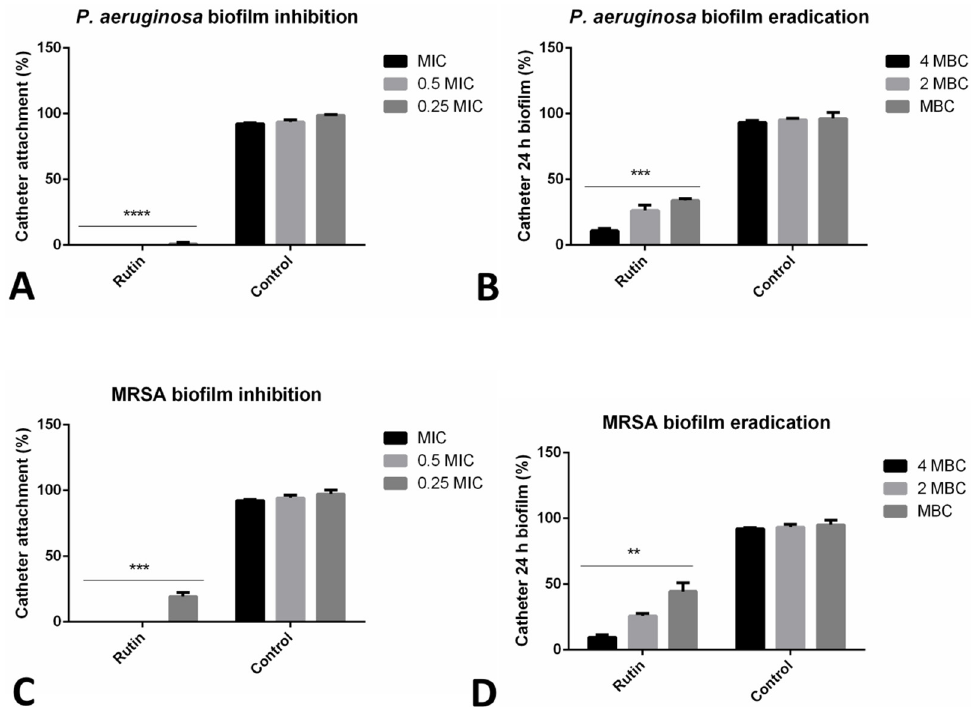
Figure 2. Impact of rutin on biofilm prevention and biofilm eradication on catheter biofilm model. P. aeruginosa IBRS P001 cell attachment on catheter surface ( A ); 24 h old P. aeruginosa biofilm ( B ); MRSA IBRS MRSA011 cell attachment on catheter surface ( C ) and 24 h old MRSA biofilms ( D ) upon treatment with rutin. The asterisks represent statistical significance **, p ≤ 0.01; ***, p ≤ 0.001; ****, p ≤ 0.0001, the data are presented as mean ± SD.